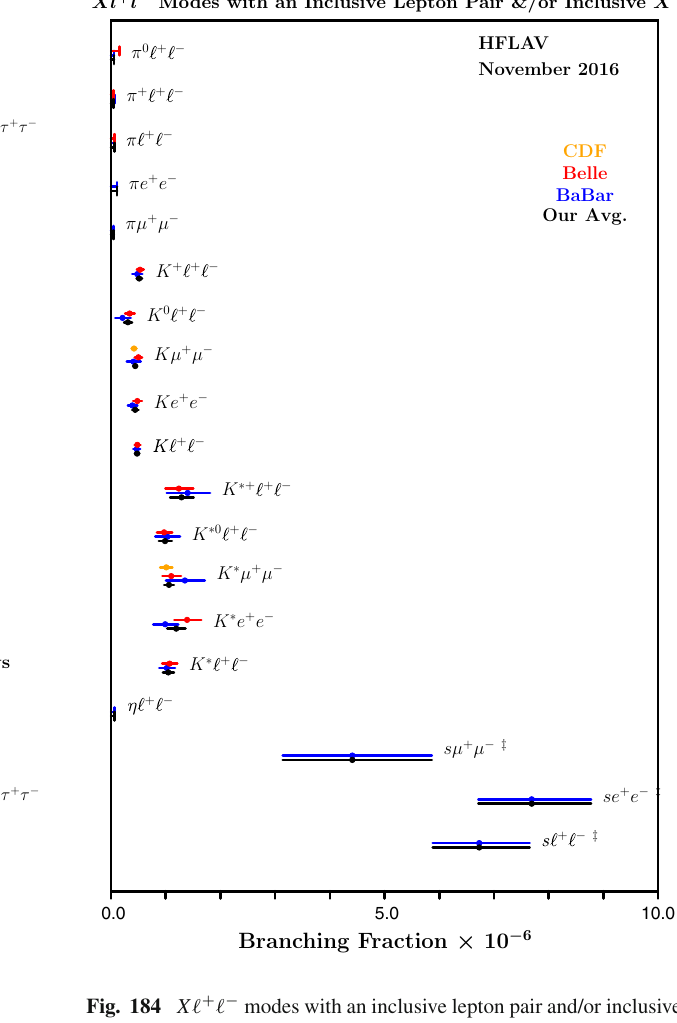
Fig. 184 X (cid:12) + (cid:12) − modes with an inclusive lepton pair and/or